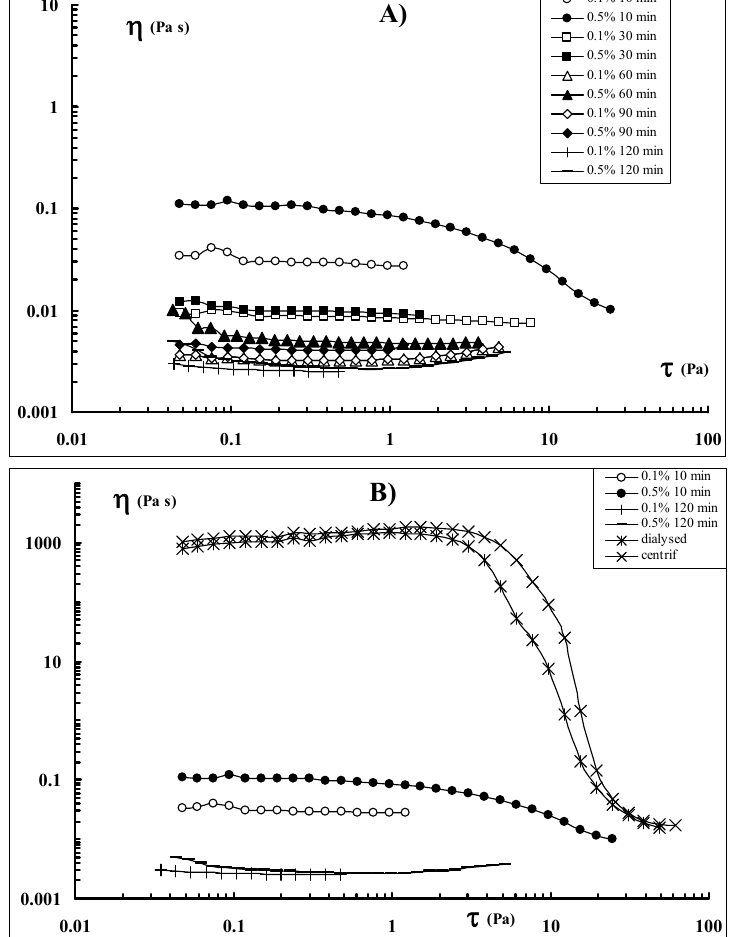
Figure 1. (A) Flow curves of Sclg samples sonicated at cp = 0.1% (open symbols) and cp = 0.5% (full symbols) for different periods of time. (B) Flow curves of Sclg sonicated for 10 and 120 min at cp= 0.1 and 0.5%. For comparison, also the flow curves recorded for the dialysed Sclg and the centrifuged Sclg, are reported (cp = 0.7%, T = 25 °C).